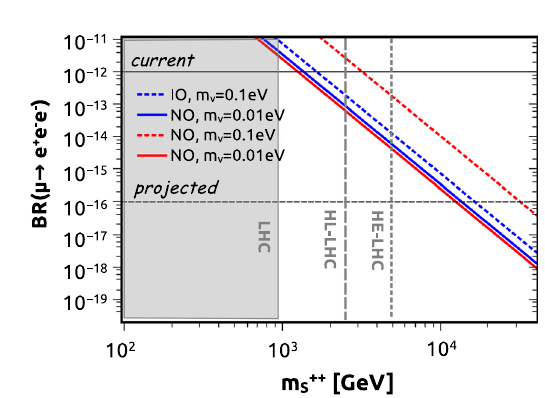
We also show the HL-LHC, and HE-LHC sensitivities which represent the LHC running with the 14 TeV − 3 ab − 1 and 27 TeV − 15 ab − 1 configurations. It is clear from the figures that the neutrino mass order- ing has a great impact on the theoretical predictions for lepton flavor violation. See text for a detailed